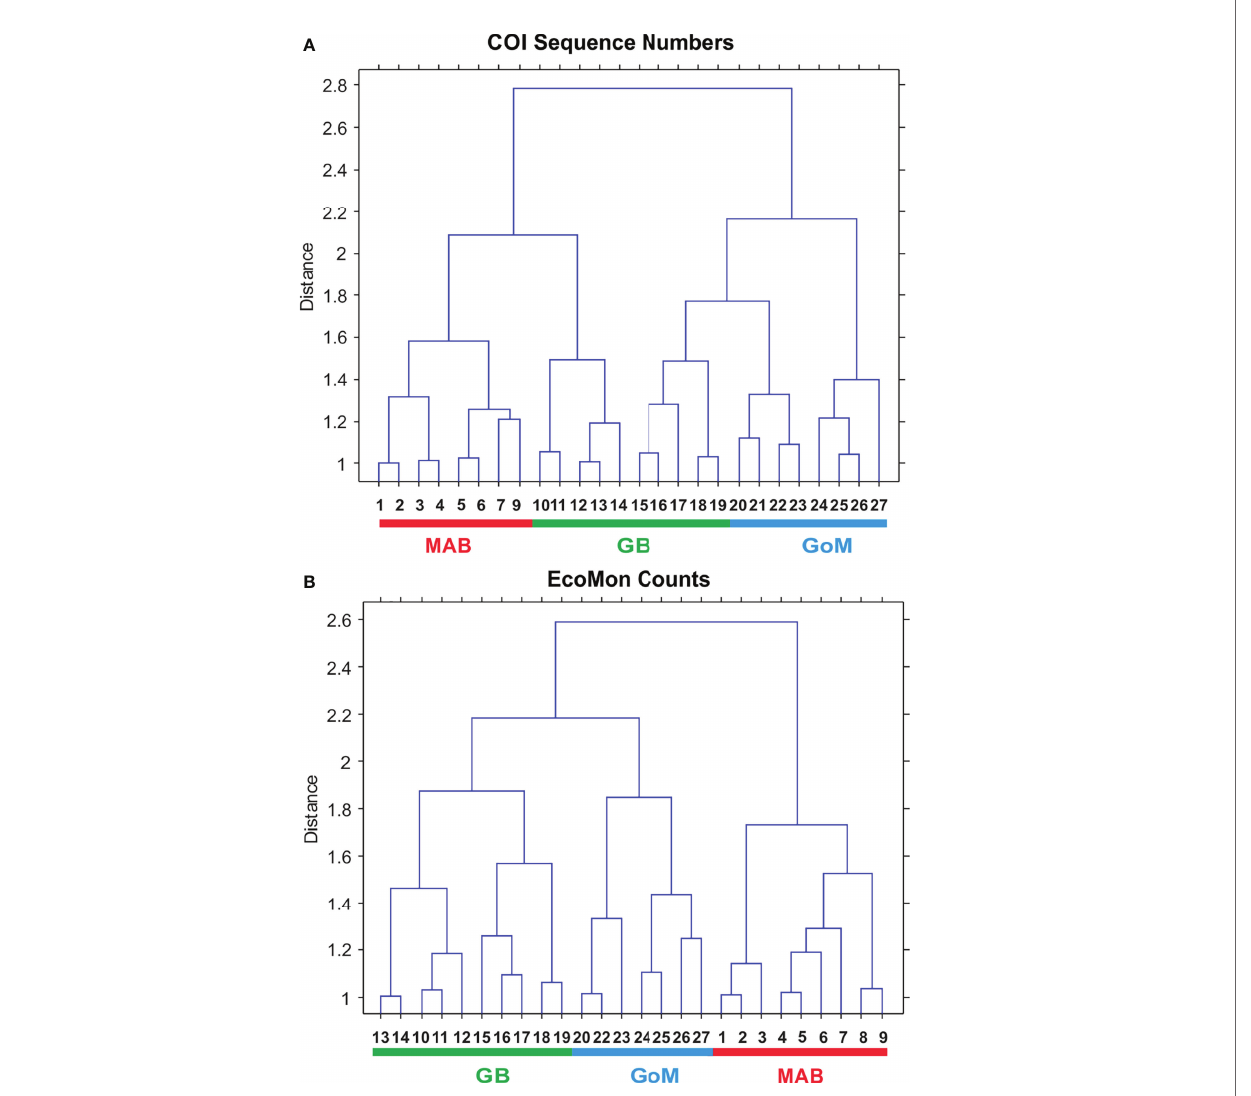
FIGURE 5 | Bray Curtis similarity cluster diagram showing analysis of regional variation based on (A) COI sequence numbers and (B) EcoMon microscopic counts for 6 taxonomic groups. Numbers are EcoMon sample numbers; see Table 1 for collection information. The three regions are indicated as Mid-Atlantic Bight (MAB), Georges Bank (GB), and Gulf of Maine